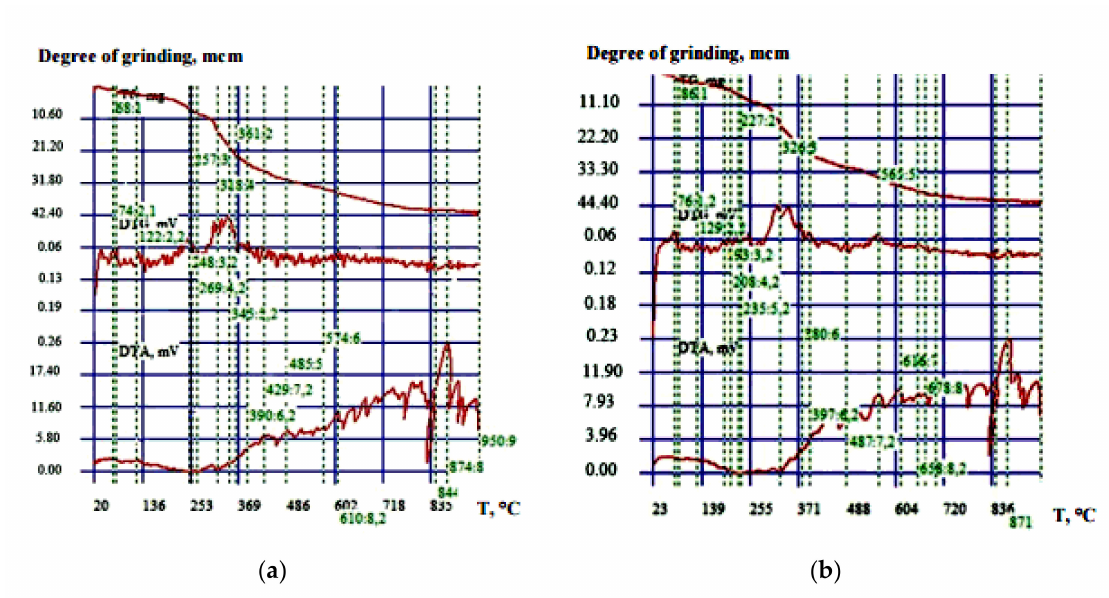
Figure 8. The thermograms: ( a ) paint sample without acid; ( b ) paint sample with 1% acid.